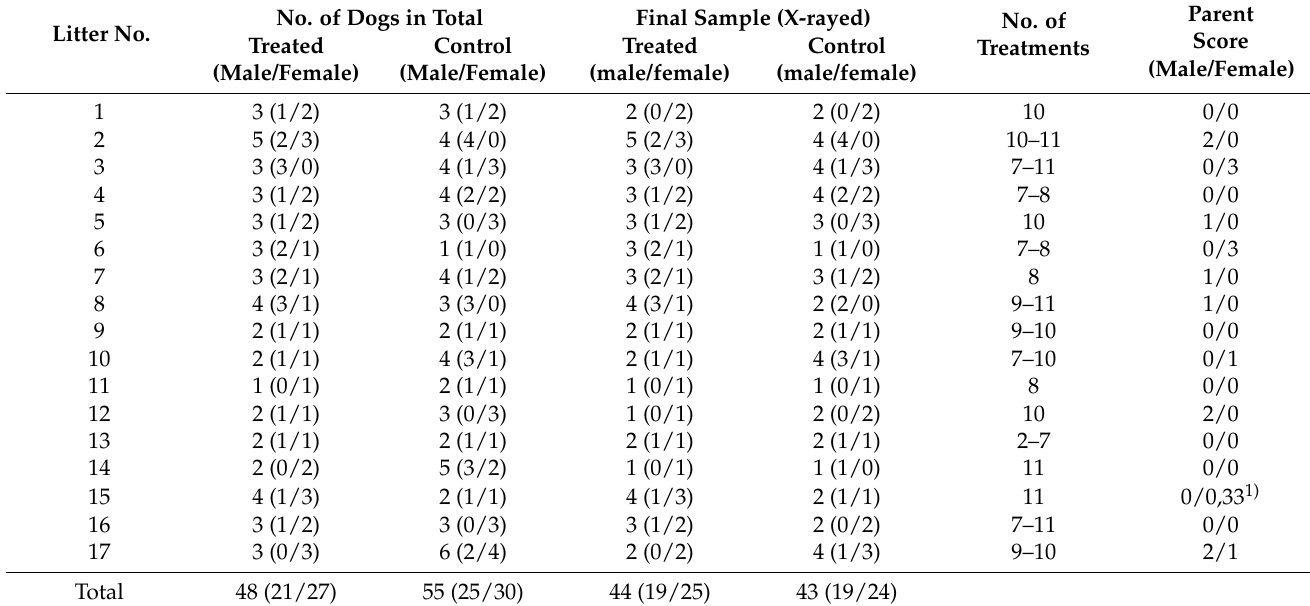
Table 1. Summary of litters included in the study. The number of puppies that were X-rayed make up the final sample included in the statistical analyses. Details on the variables recorded for the individual dogs included in the final sample, including their spondylosis score, are available as Supplementary Material in Table S1. Litter